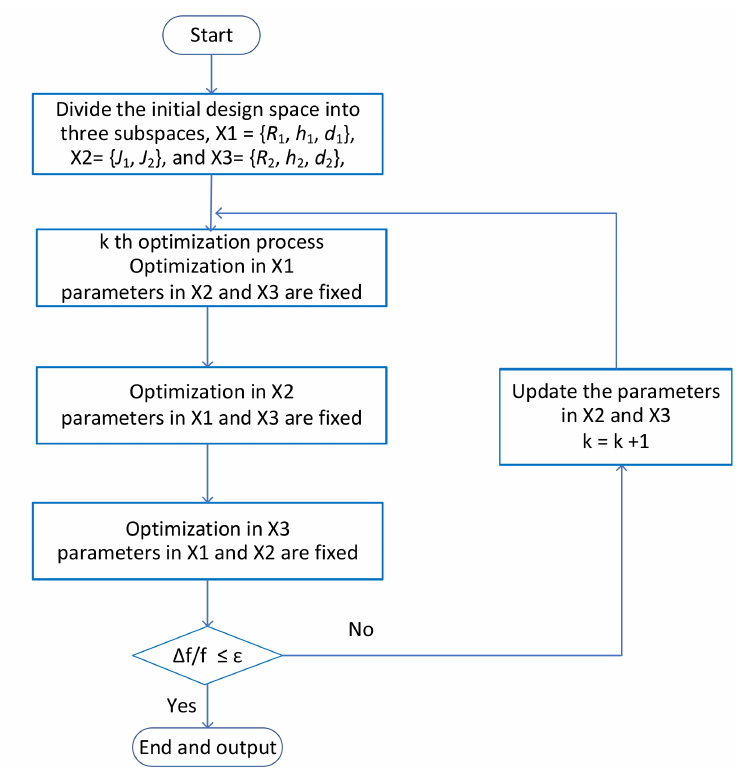
Figure 6. A three-level optimization flowchart for SEMS, in which 8 optimization parameters are allocated to three subspaces X1, X2, and